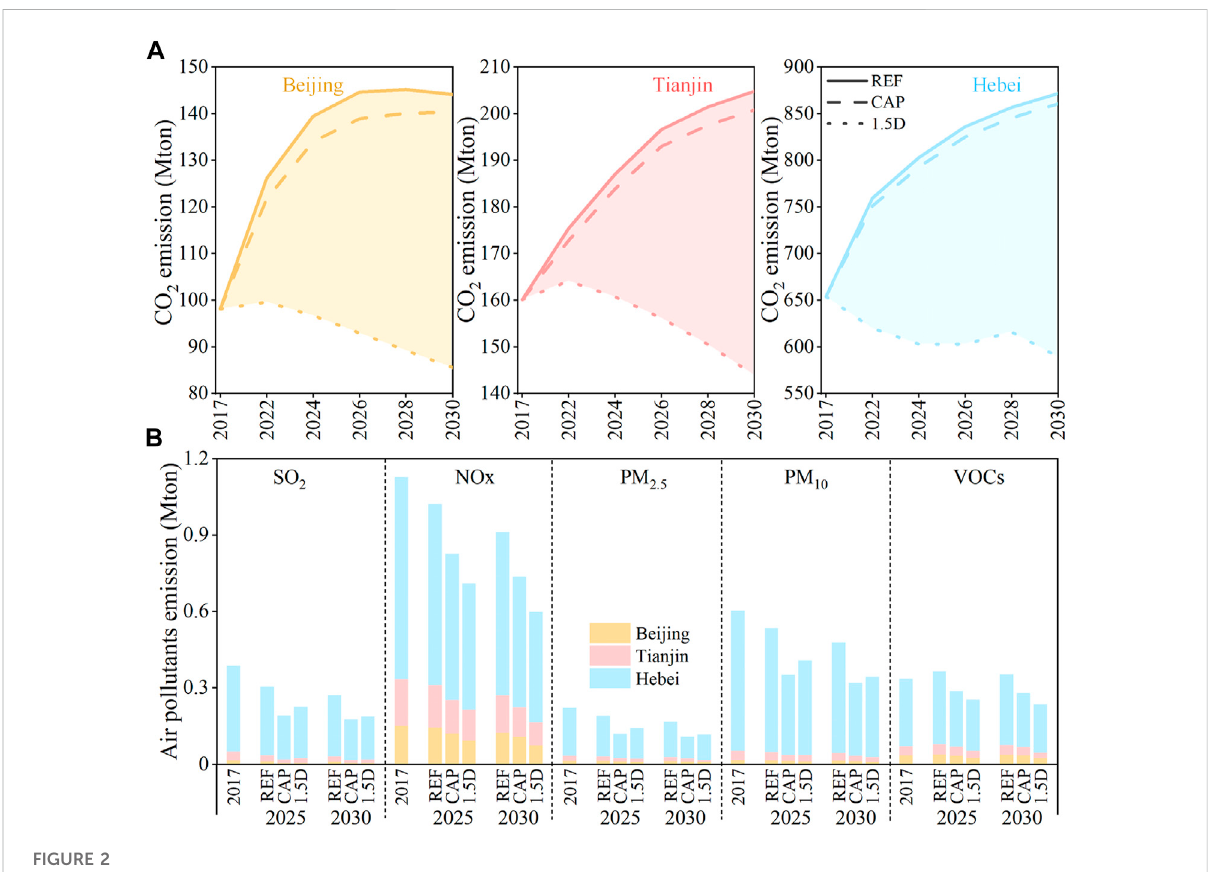
FIGURE 2 CO 2 (A) and air pollutants (B) emissions in Beijing, Tianjin and